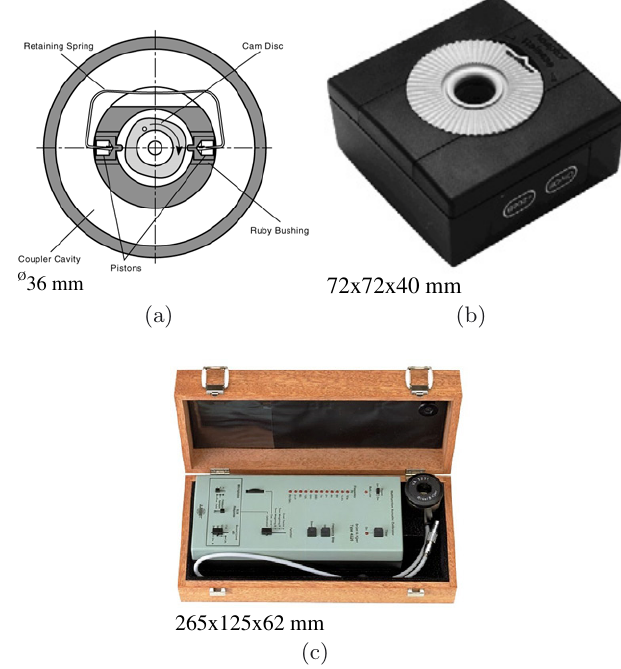
Fig. 19. (a) Operation principle of pistonphone. (b) Typi- cal feed-back calibrator 94 dB, 1000 Hz. (c) Multi-frequency calibrator 94 dB–114 dB, 31.5 Hz–16